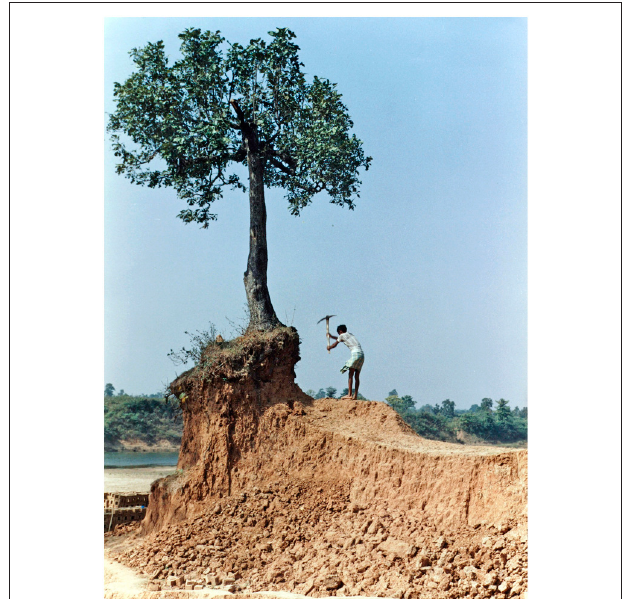
FIGURE 4 | Illustration of a local situation involving competing soil uses, where reasoning in terms of a transition from one traditional type of stable, large-scale ecosystem to another appears ill-adapted (Modified from http://www.unep.org/depi/ Ecosystemservicesandeconomics/tabid/6389/Default.aspx).